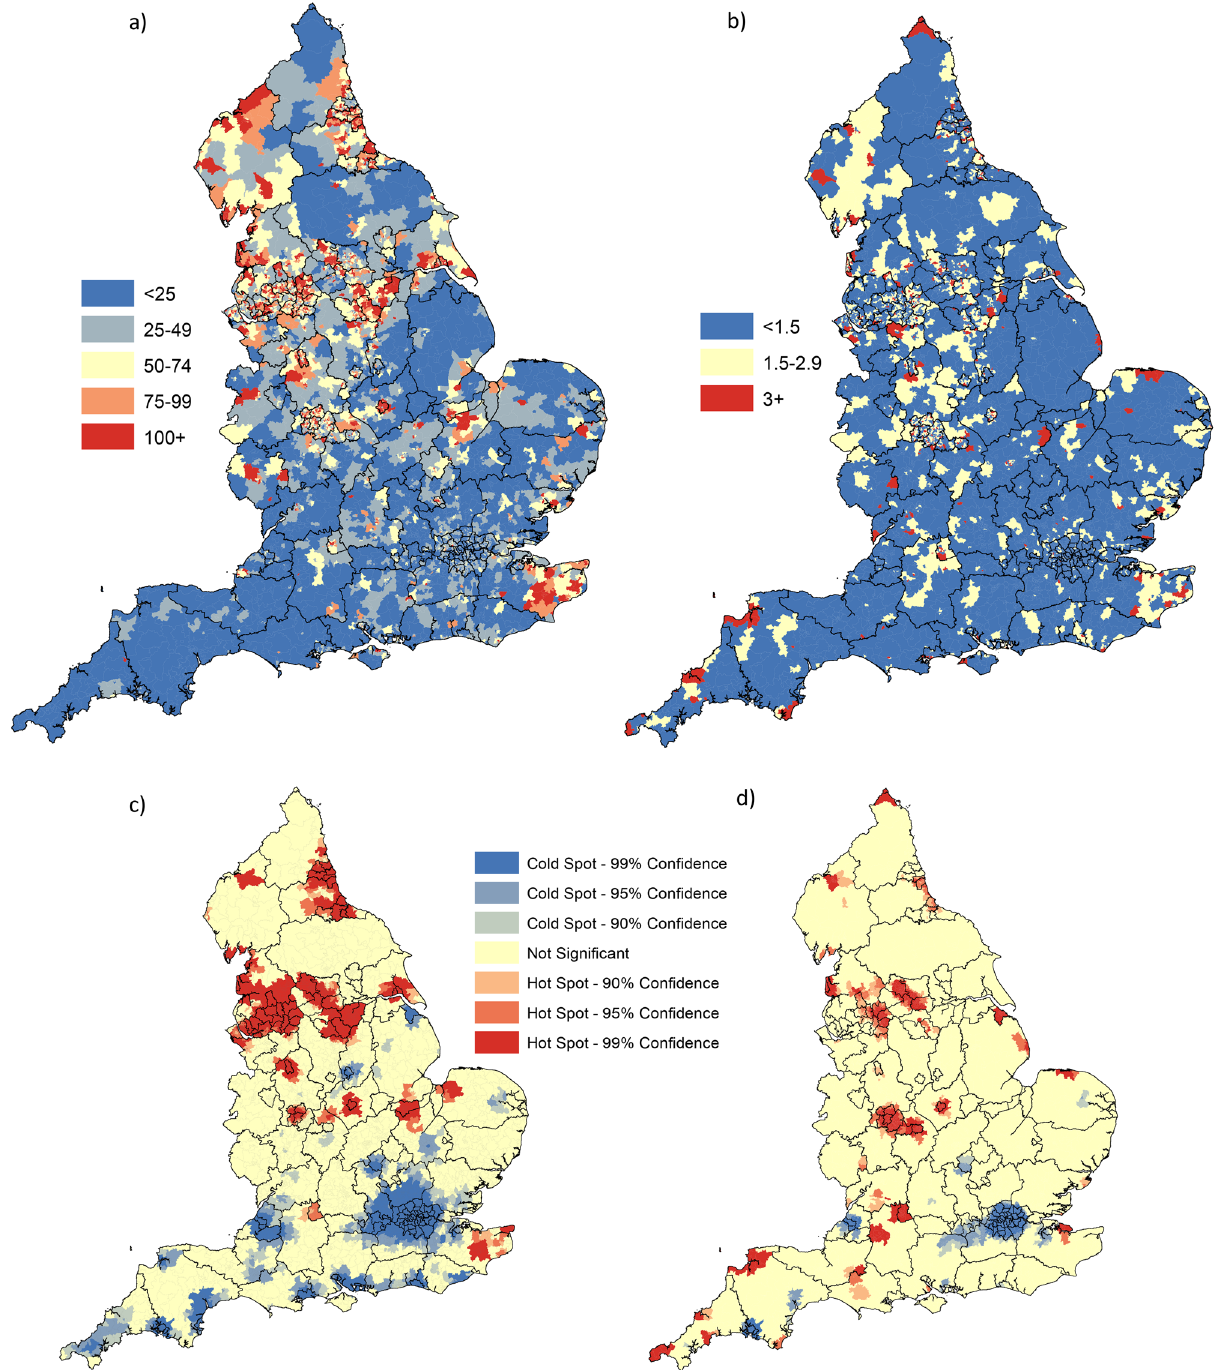
level for week 34 to 40, 2020. Maps constructed using ArcGIS 10.5 (https:// deskt op. arcgis. com/